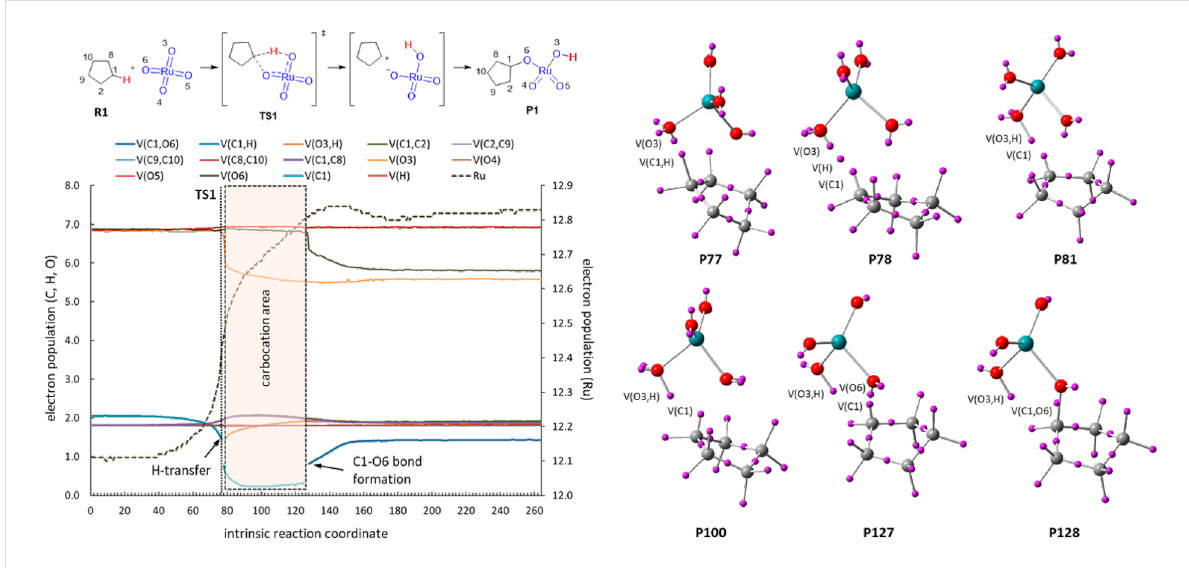
Figure 2: ELF analysis for the oxidation of cyclopentane ( R1 ). Left: evolution of the electron population along the IRC. Right: Descriptors of basins at selected points of the IRC.